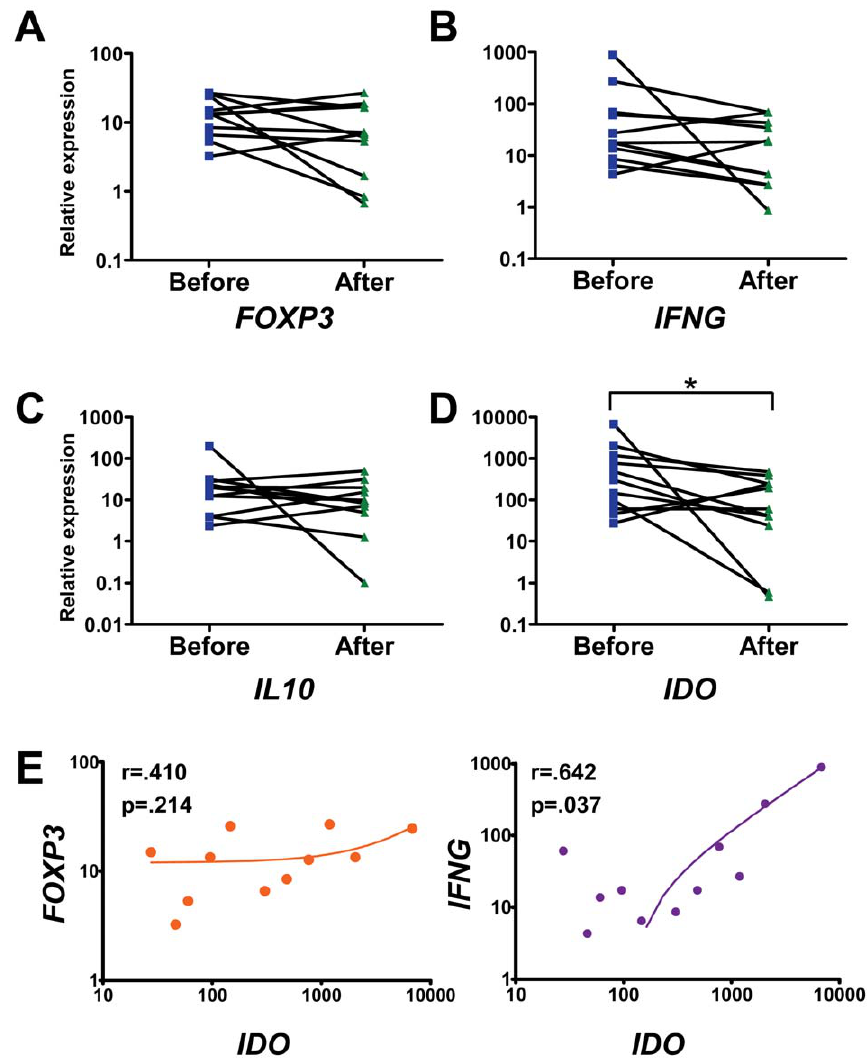
Figure 5. Relative expression of IDO decreases in CDL patients after treatment and is correlated with IFNG . RNA was isolated from biopsies of lesions from CDL patients (n=11) before and after treatment and the expression of FOXP3 ( A ), IFNG ( B ), IL10 ( C ) and IDO ( D ) was measured by qRT-PCR. The expression of each gene relative to healthy skin of four normal controls was calculated using the DD CT method. E . Correlation between the relative expression of IDO and FOXP3 (left panel) or IFNG (right panel). *p , 0.05, Wilcoxon signed-rank